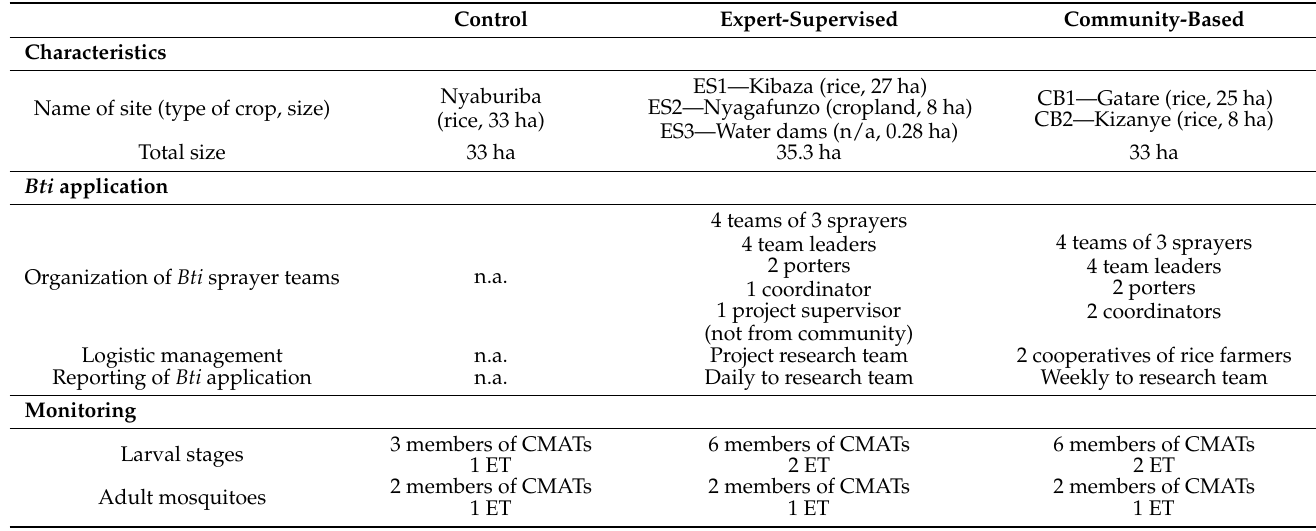
Table A1. Table with main characteristics of the experimental sites, organizational structures of Bti application and entomology monitoring of larval and adult stages of mosquitoes in the study